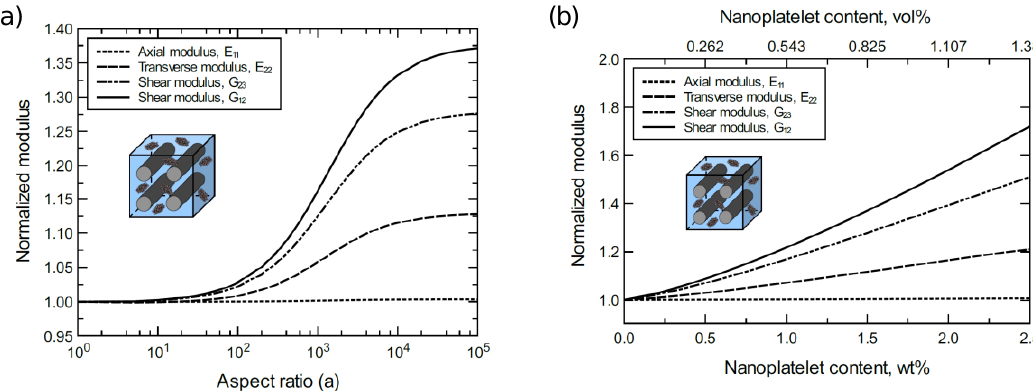
Figure 4. Normalized elastic and shear moduli for unidirectional CF/GNP/epoxy ( a ) at 1.0 wt% of GNP content and various GNP aspect ratios, ( b ) at 10 3 GNP aspect ratio and various GNP contents. The volume fraction of CF is 56%.